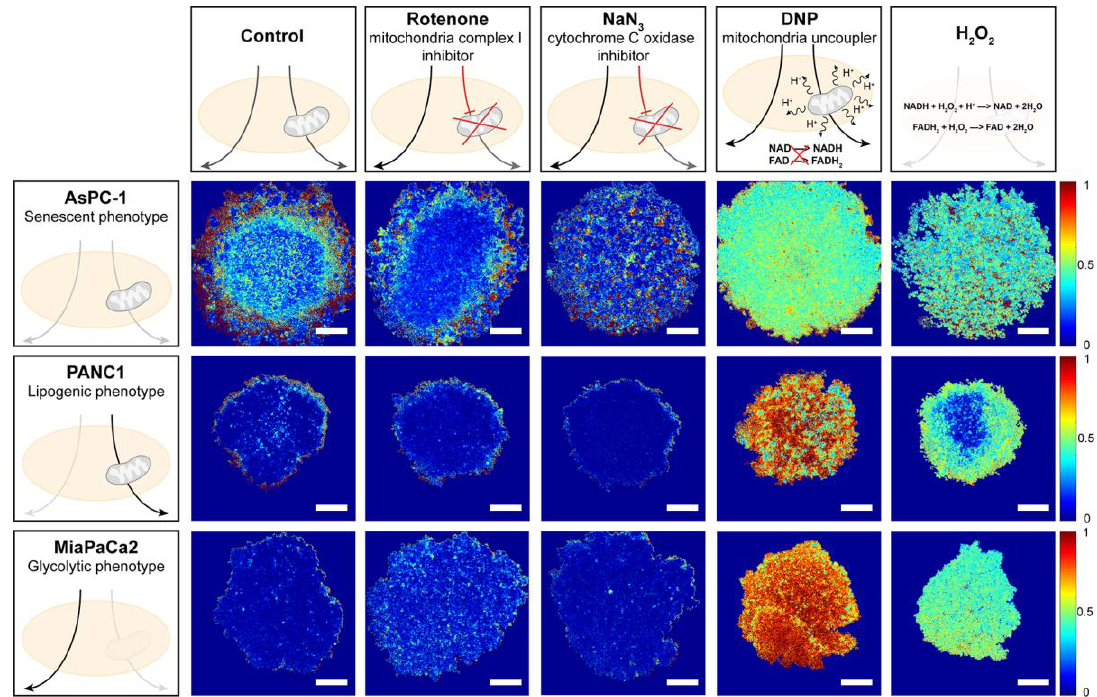
Figure 2. Proof of concept of the redox imaging protocol; image analysis demonstrates the metabolic differences between spheroids of varying pancreatic cancer cell lines. Image analysis outputs demonstrating the optical redox ratio (ORR) spatial distribution throughout the tumor spheroids of PanCa cancer cell lines following exposure to modulators of the reduced nicotinamide dinucleotide (NAD(P)H) and oxidized flavoprotein adenine dinucleotide (NAD(P)H/FAD) balance as illustrated. Scale bar = 250 µm.